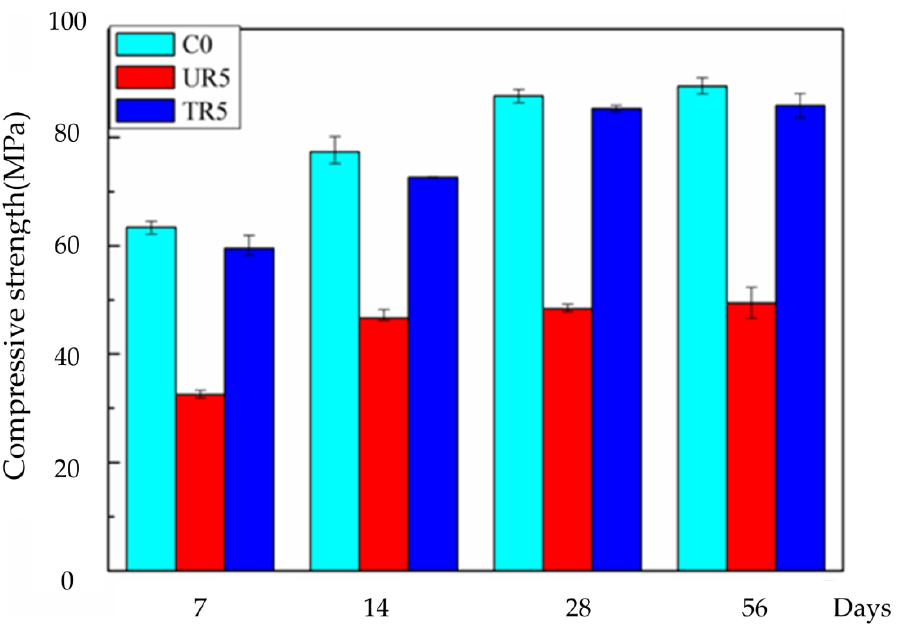
Figure 14. Compressive strength values of different cement